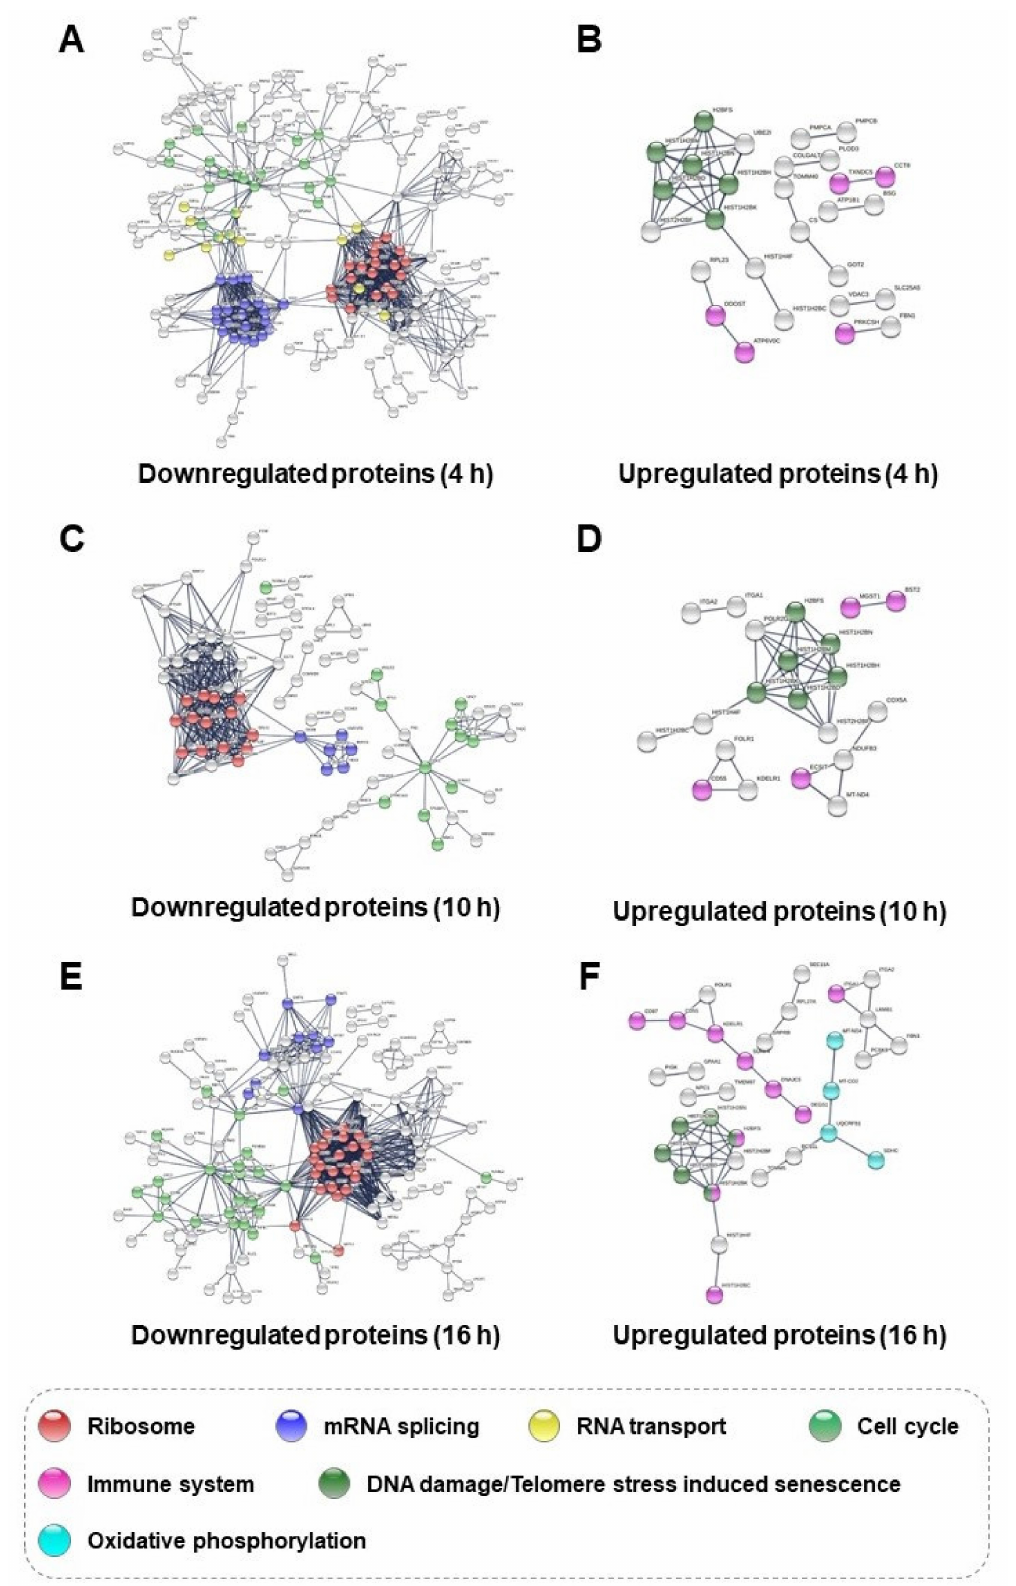
Figure 4. Protein–protein interaction networks (PPI) of differentially expressed proteins in HepG2 cells regulated by SiO 2 NPs using a STRING algorithm. The color circles represent the cellular interaction with highest confidence (score ≥ 0.9) are shown. PPI of downregulated and upregulated proteins for ( A , B ) 4, ( C , D ) 10, and ( E , F ) 16 h